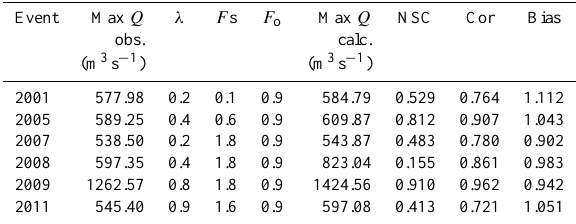
Table 3. Flood events in the Tonalá River used in the calibration process of free parameters in the hydrological model, along with computed error